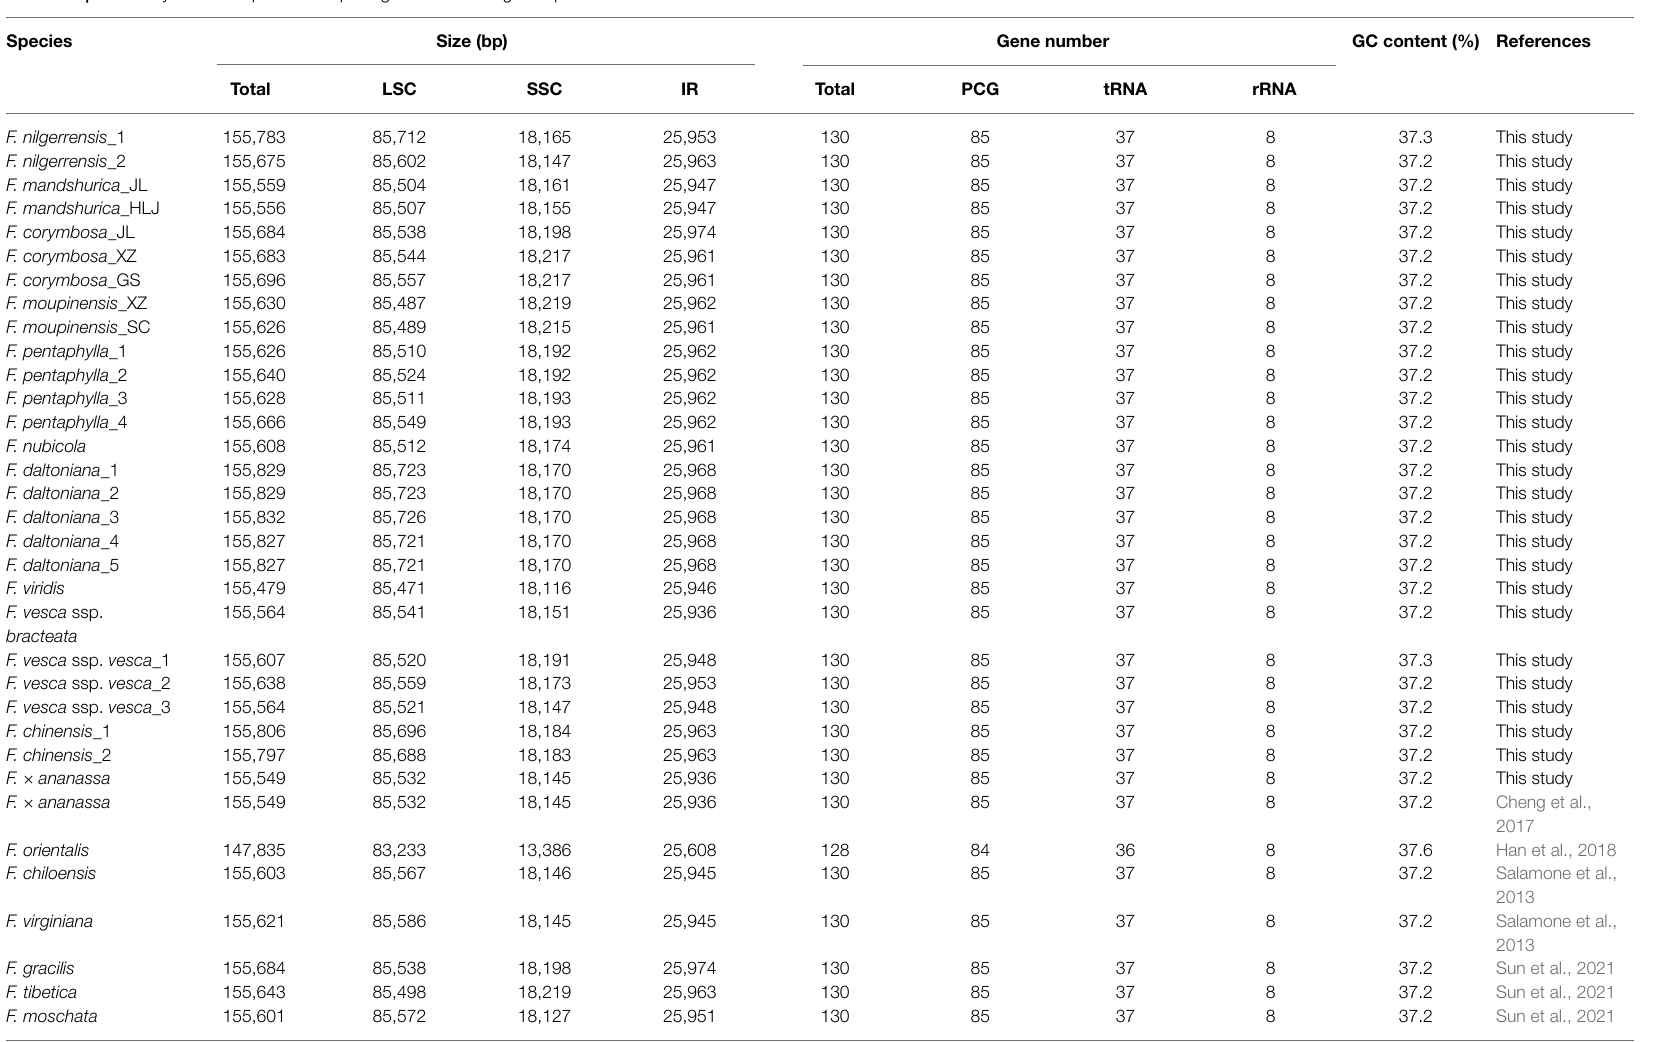
TABLE 2 | Summary of 34 complete chloroplast genomes for Fragaria species.